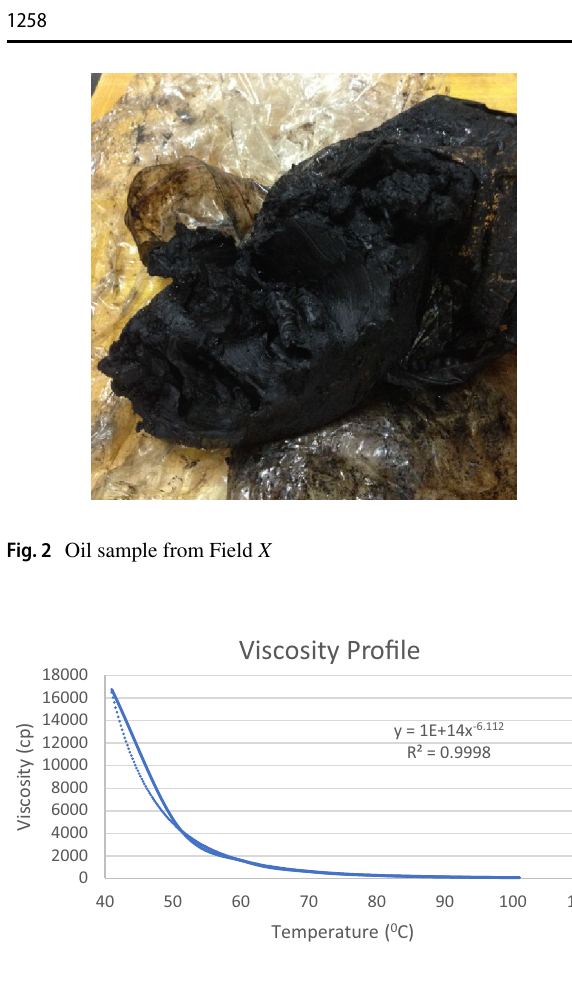
Fig. 3 Viscosity profile of oil X vs temperature